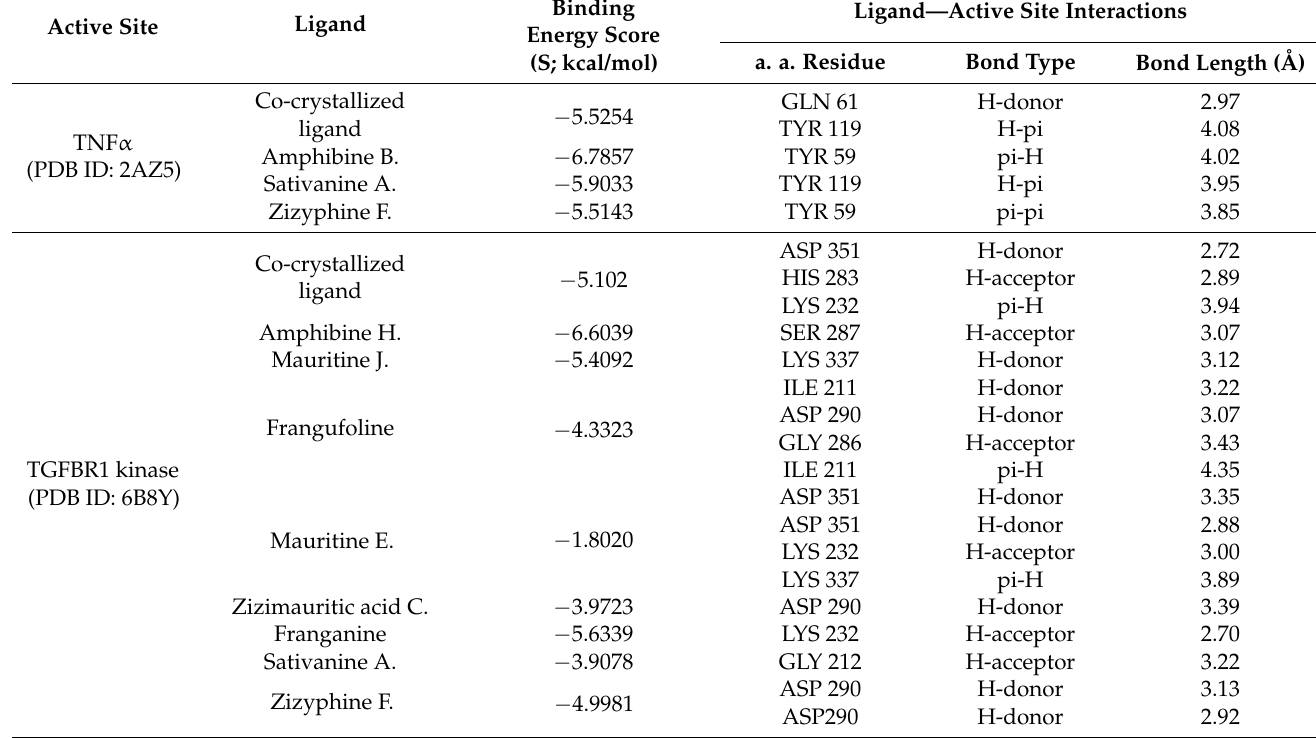
Table 6. Binding free energy score (S; kcal/mol) and binding interactions for different co-crystallized ligands and ZFE-derived compounds within TNF α (PDB ID: 2AZ5); TGFBR1 kinase (PDB ID: 6B8Y); and Interleukin 1 β (PDB ID: 6Y8M) active